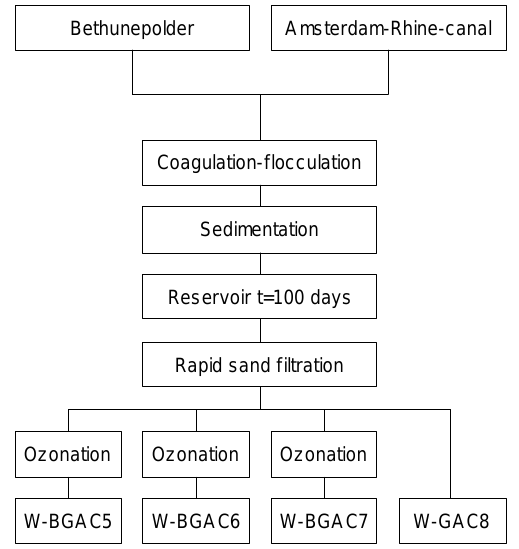
Figure 1. Flow scheme at the Weesperkarspel pilot